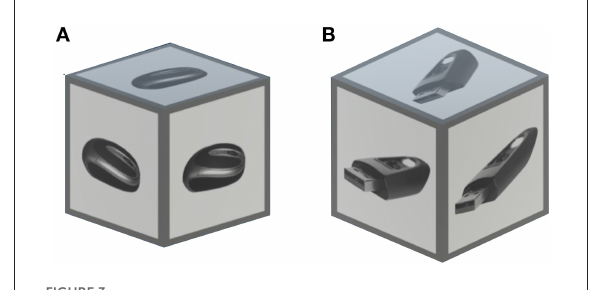
FIGURE3 An example of (A) target object and (B) distractor used in the experiment. The objects were represented by grayscale images projected on the cube facets. The size of the cubes was set to 0 . 084Unity-meters. Here, both the target object and the distractor, belong to the same scene context: office. For details, see Section 2.3.2.